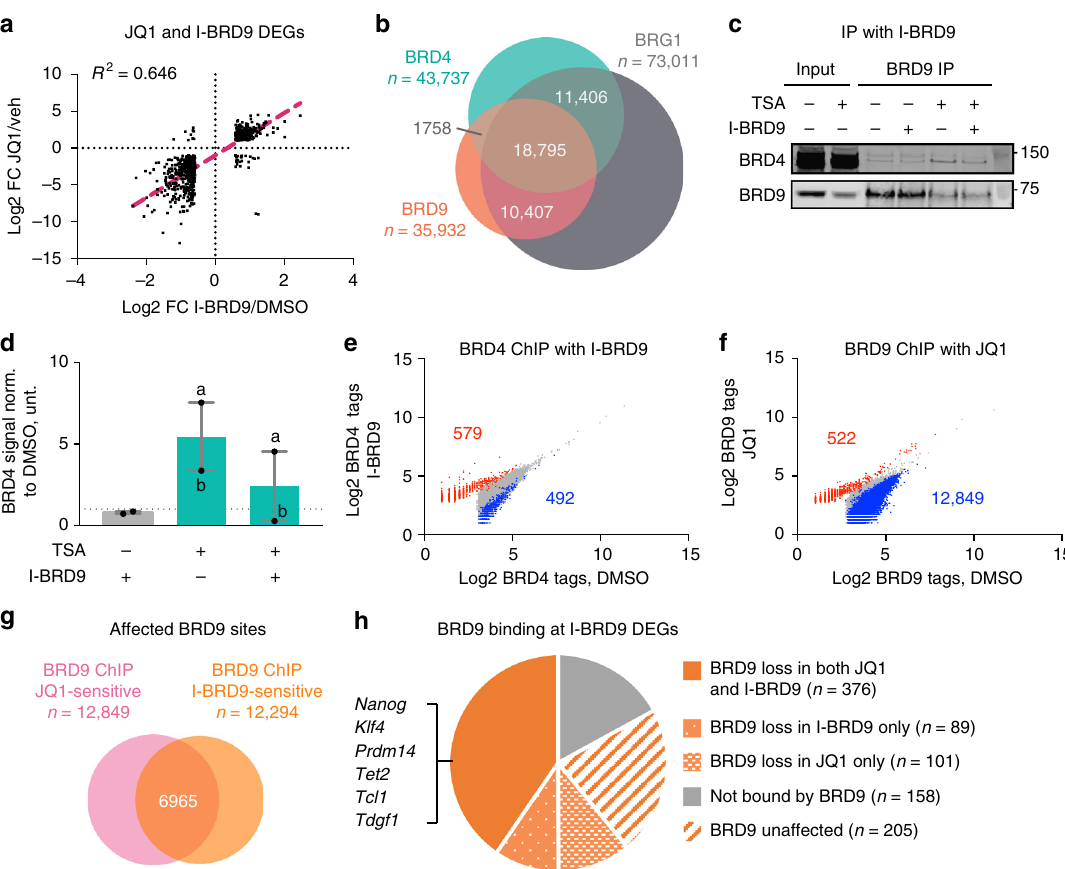
Fig. 7 BRD4 recruits GBAF to target gene sites in a BD-dependent manner. a Scatterplot of the mRNA log2 FCs in I-BRD9/DMSO and JQ1/vehicle for 664 common DEGs. Linear regression analysis was performed to calculate the R 2 , with the best fi t shown as a pink dashed line. b Venn diagram of overlaps between BRG1, BRD9, and BRD4 ChIP binding sites in ESCs, with n representing the number of observed peaks. c ESCs were treated with either DMSO